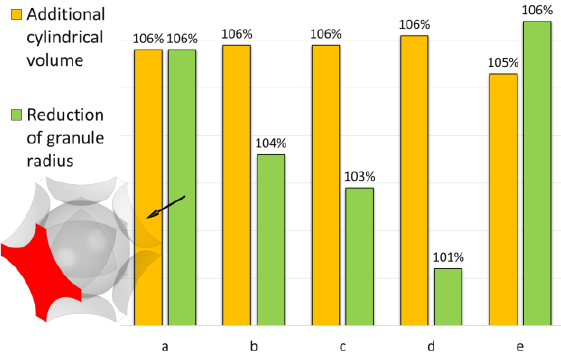
Fig. 7. Average relative velocity magnitude on outlet surface The discretization method with additional cylindrical volume is characterized by relatively stable average velocity along outlet line (variation of 3%) and on outlet surface (variation of 1%) for each of the analysed radius of the cylindrical volume ( R cyl% ). The variations of average velocity are more significant (18% and 5% respectively) for the method of granule radius